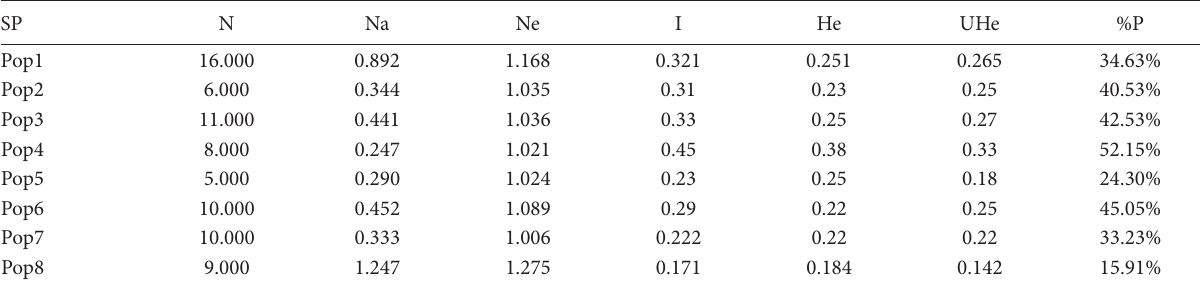
Table 3. Genetic diversity parameters in the studied Salicornia persica